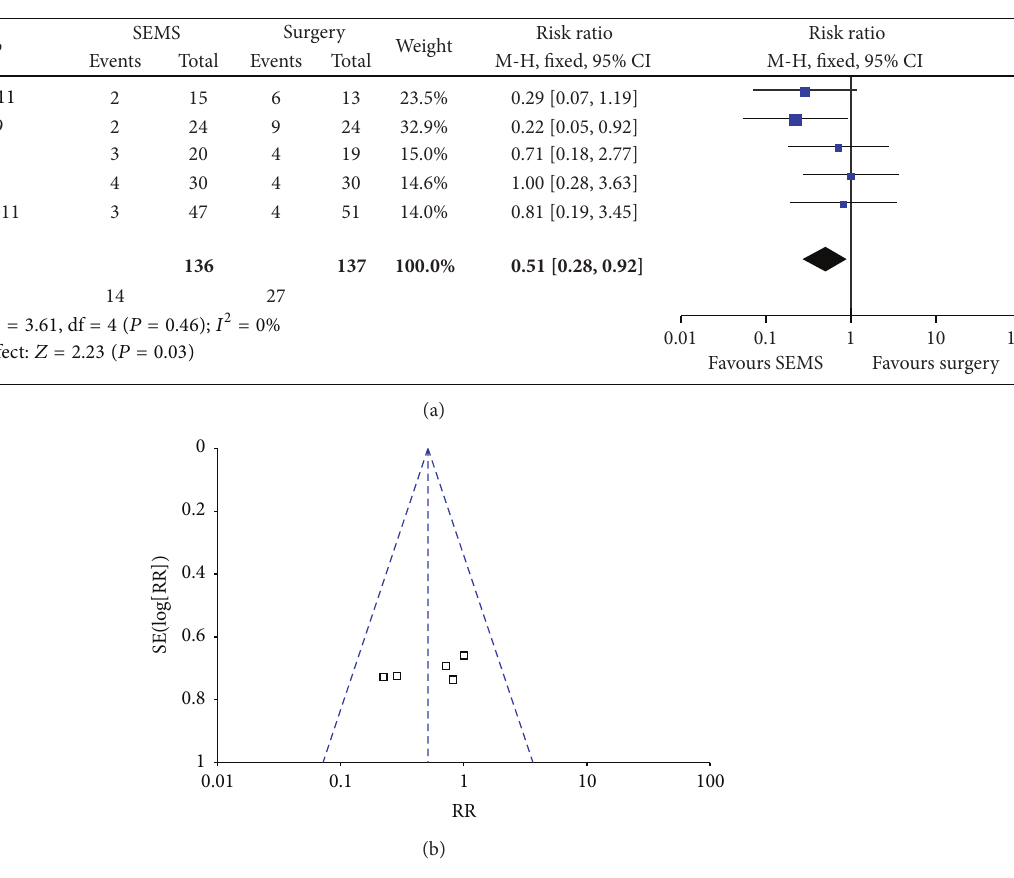
Figure 7: Forest plot and funnel plot of